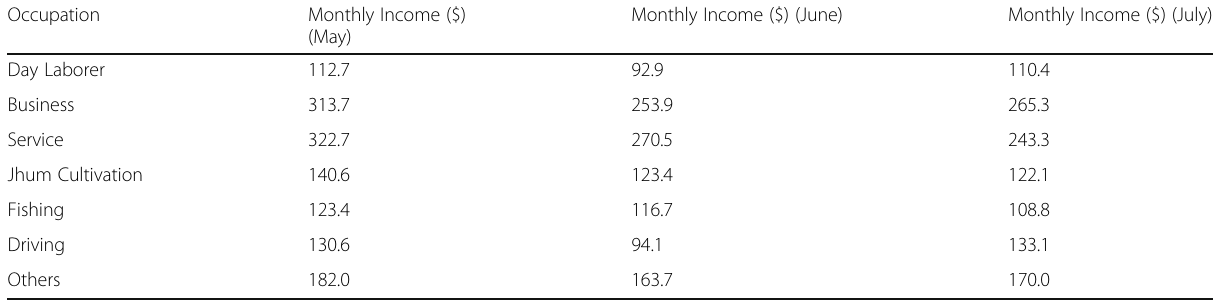
The mean monthly incomes (Table 7) for different jobs before landslides were significantly different from the mean monthly incomes of during and after land- slides for all the jobs except jhum cultivation and Table 6 Monthly Income of the Landslides Affected People before (May), During (June) and After (July)